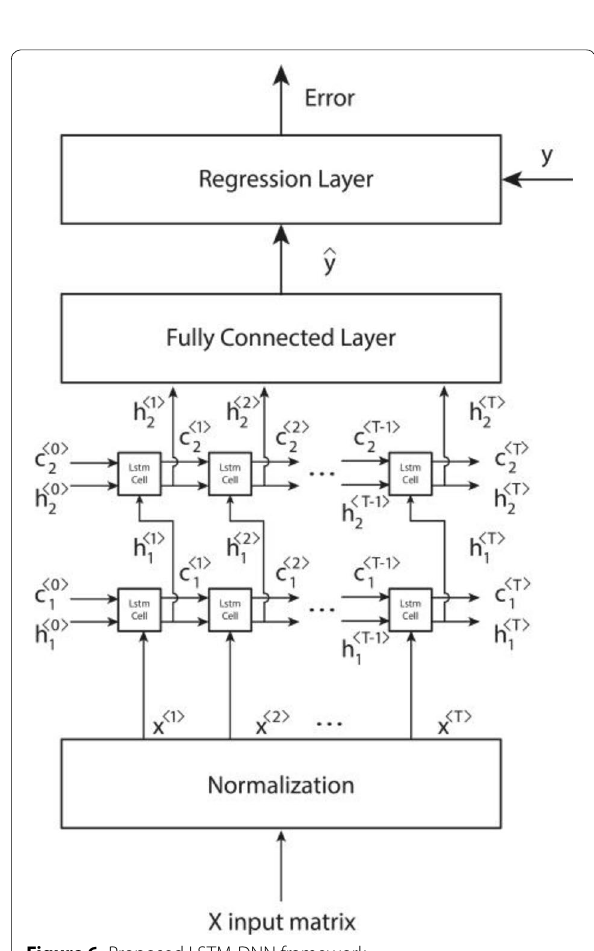
Figure 6 Proposed LSTM-DNN framework